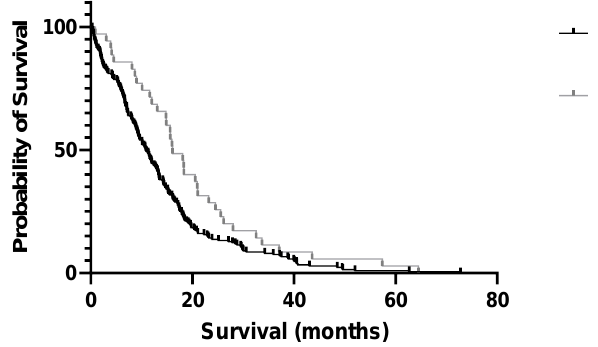
Figure 3. Survival curve for PSMA high expression vs. low expression.